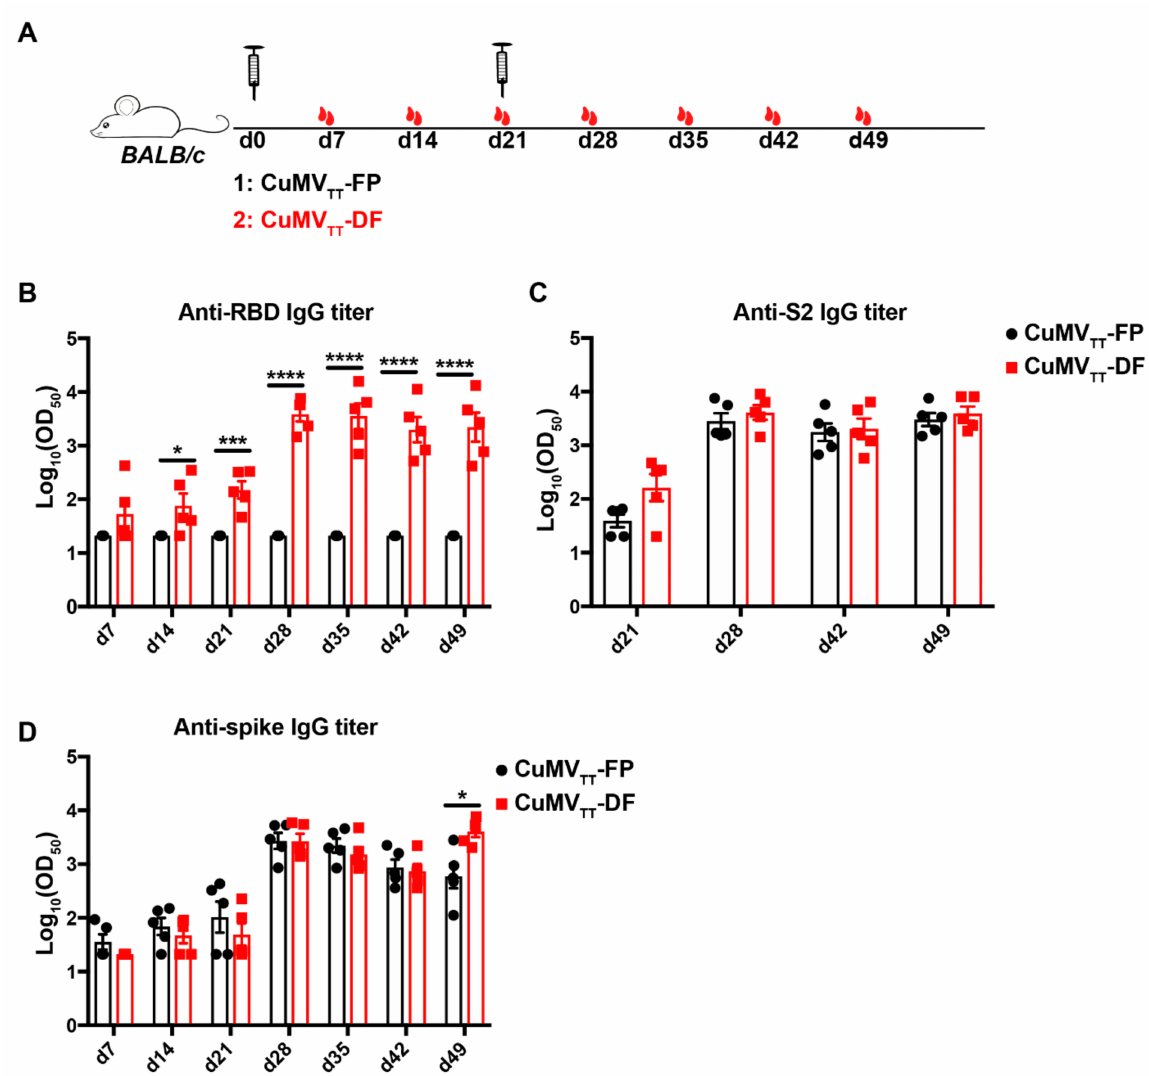
Figure 2. Immunogenicity examination of CuMV TT -FP and CuMV TT -DF vaccines in mice. ( A ): Immunization regimen: BALB/c mice were subcutaneously injected with 100 ug CuMV TT -FP or CuMV TT -DF vaccine at d0 and d21. Serum samples were collected every week until d49 ( n = 5). ( B – D ): IgG antibody titers of immunized mice against RBD ( B ), S2 protein ( C ) and spike protein ( D ). Unpaired t -test analysis was performed in GraphPad Prism 7. α = 0.05 and statistical significance were displayed as p ≤ 0.05 (*), p ≤ 0.005 (***), p ≤ 0.001